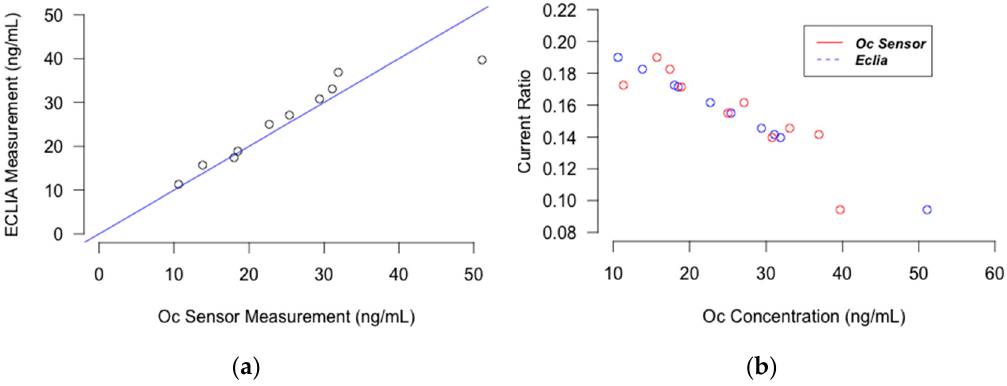
Figure 3. Plot displaying ( a ) the correlation between Osteokit and ECLIA results for Oc measurement ( b ) chronoamperometric response for Oc measurement using Osteokit and ECLIA.